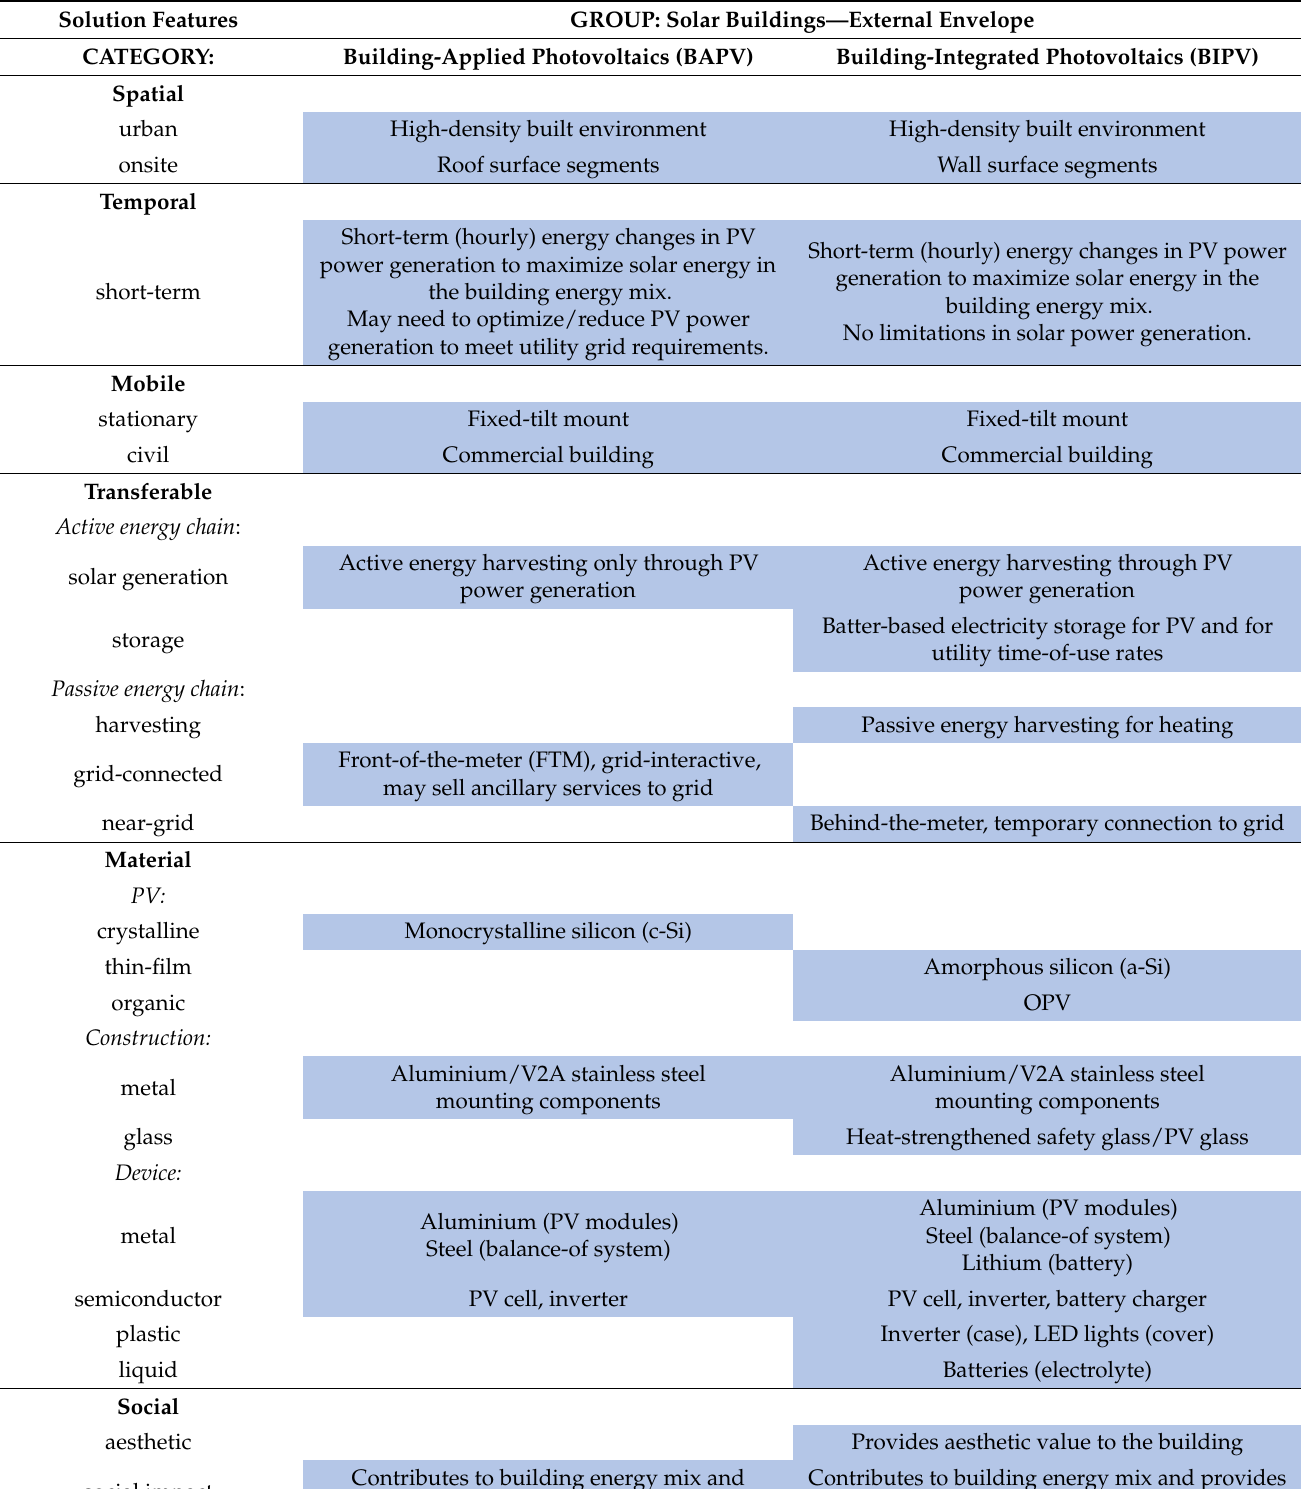
Table A1. Solar Architecture Table: Solar Buildings—External Envelope (filled cells indicate applied features of the compared